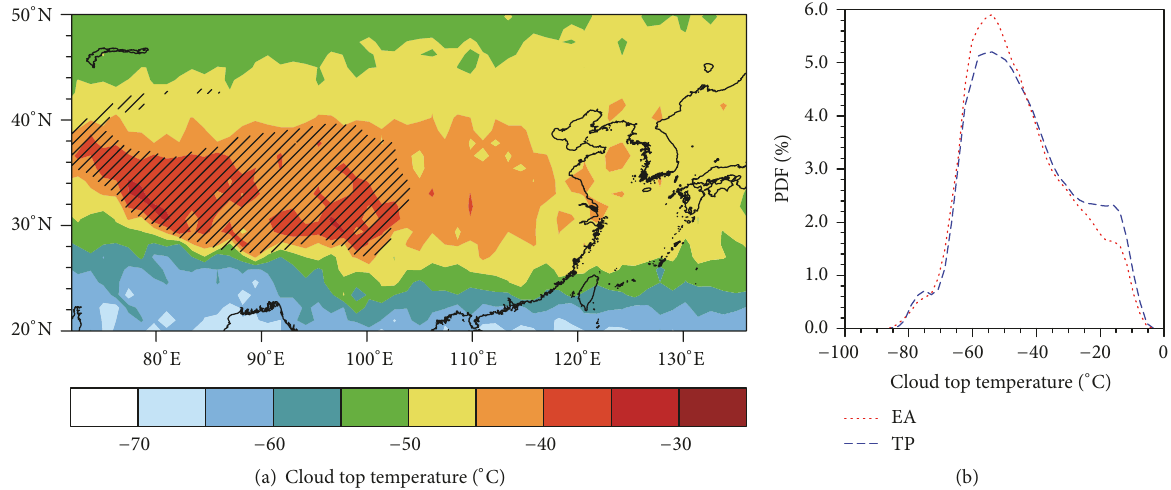
Figure 5: (a) Horizontal distribution of the cloud top temperature of single-layer cloud over China and surrounding areas; (b) PDF of the cloudtoptemperatureofsingle-layercloudoverTibetanPlateau(TP)andEastChina(EA).Theshadedpartindicatesthatthesurfaceelevation is above 3.1 km (680